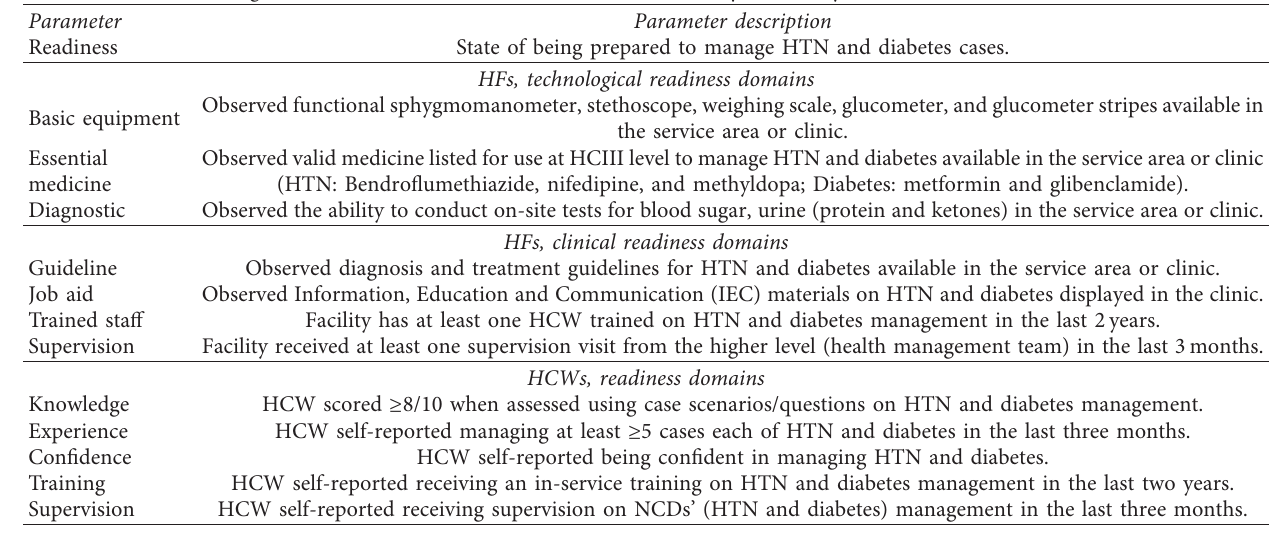
Table 1: Background characteristics of health facilities in the study site (study variables and their measurements). Parameter